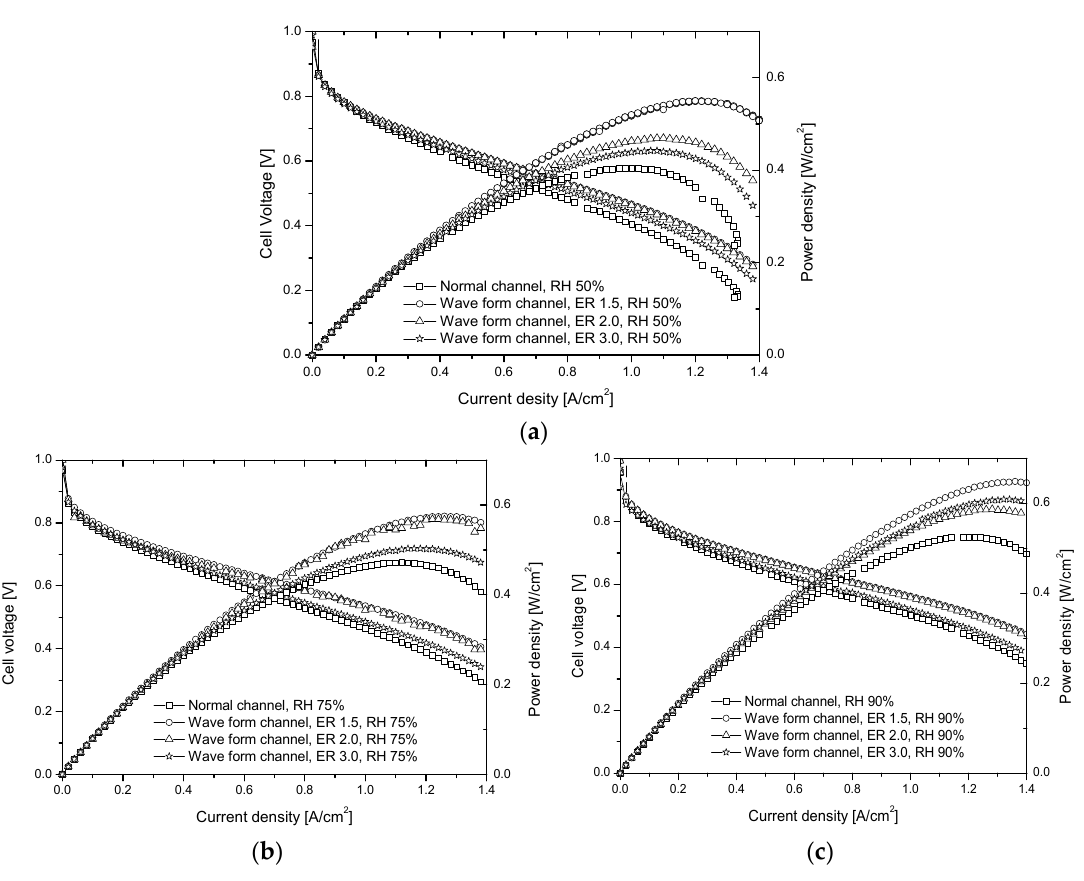
Figure 10. Performance curve of the normal channel and wave form channel, according to variation in the ER at constant relative humidity of ( a ) RH 50%, ( b ) RH 75%, and ( c ) RH 90%.